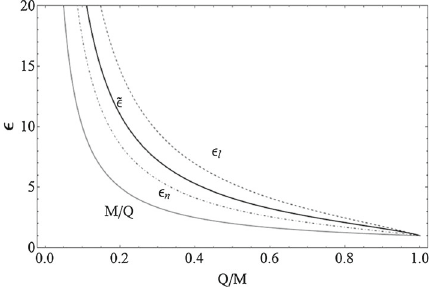
Fig. 1 The charge parameters (cid:2) l ( dashed curve )—defined in Eq. (19)—, (cid:9) (cid:2) ( black solid curve ), (cid:2) n ( dotdashed curve ), and M / Q ( gray curve ) as functions of the charge-to-mass ratio of the RN black hole